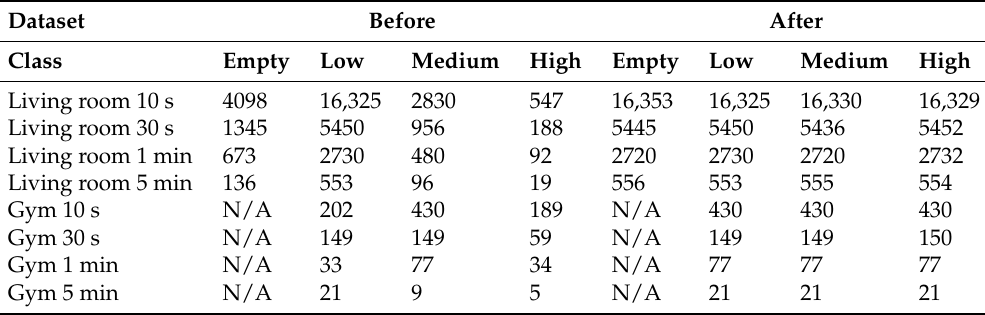
Table 2. Datasets before and after being